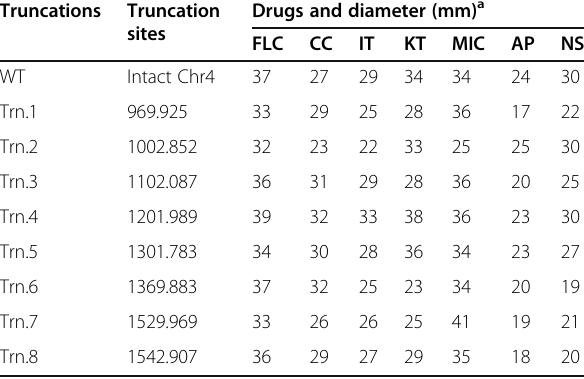
Table 4 Zone of Inhibition diameter for different drugs (mm)